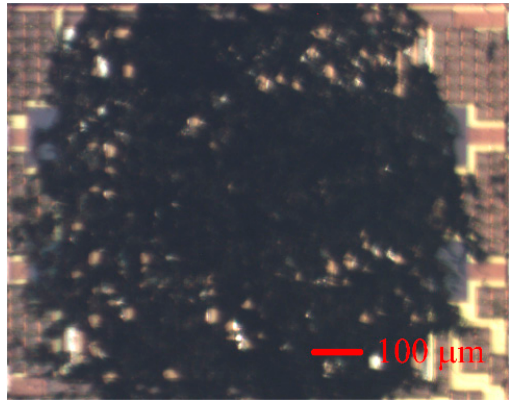
Figure 10. Optical image of the AGS after coating the sensing film.